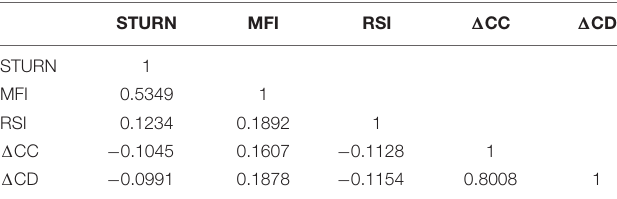
TABLE 6 | Ordinary correlations (United